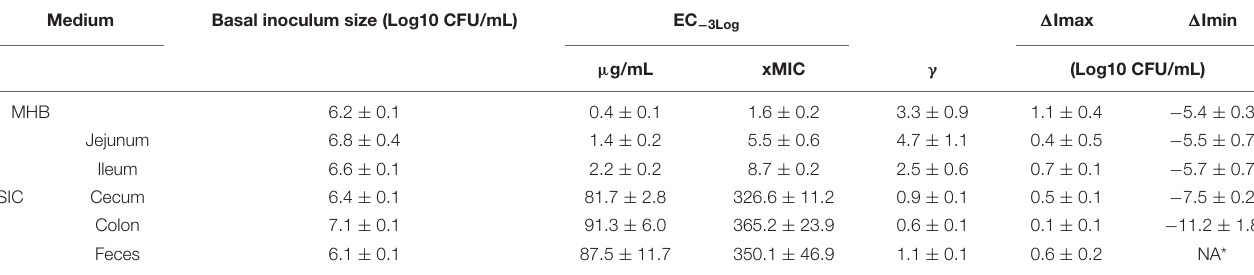
TABLE 4 | Mean ± SD pharmacodynamic parameters calculated with Equation 1 (sigmoid E max model) describing killing effects of minocycline on 2S1F2 in different matrices (MHB and SIC, from jejunum, ileum, cecum, colon, and feces). Medium